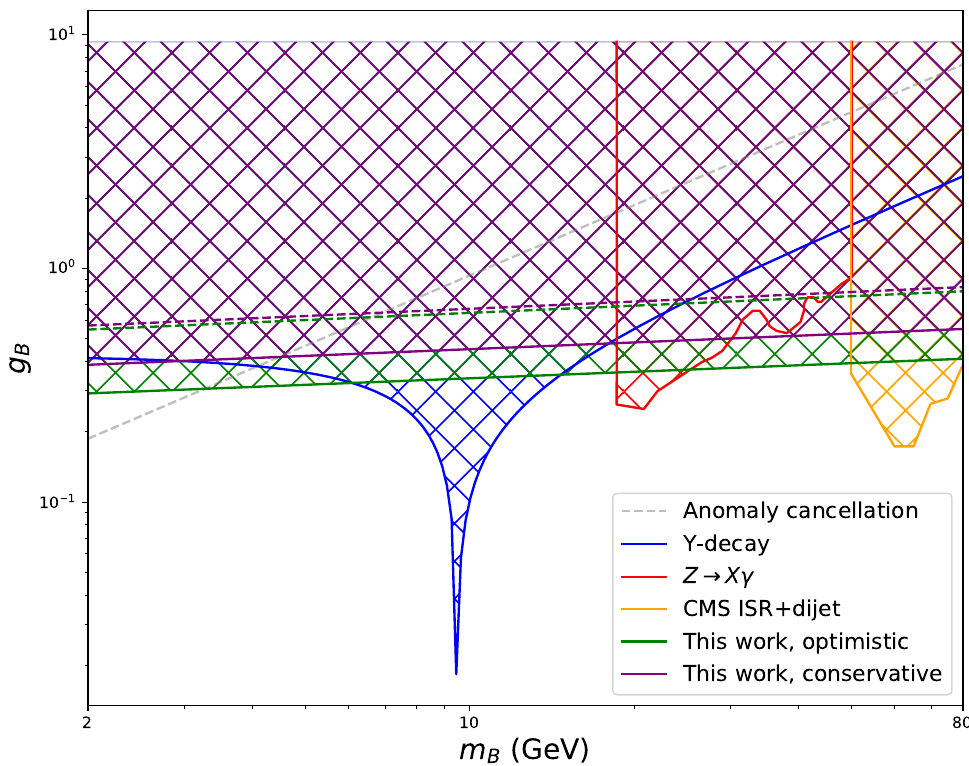
Figure 7 . Comparison of the projected HL-LHC sensitivity computed in this work in the optimistic (green) and conservative (purple) scenarios with the existing bounds described in section 3.1. The solid green and purple lines correspond to projected bounds obtained excluding projected PDF uncertainty, whilst the dashed lines correspond to projected bounds obtained including projected PDF uncertainty, as discussed in the